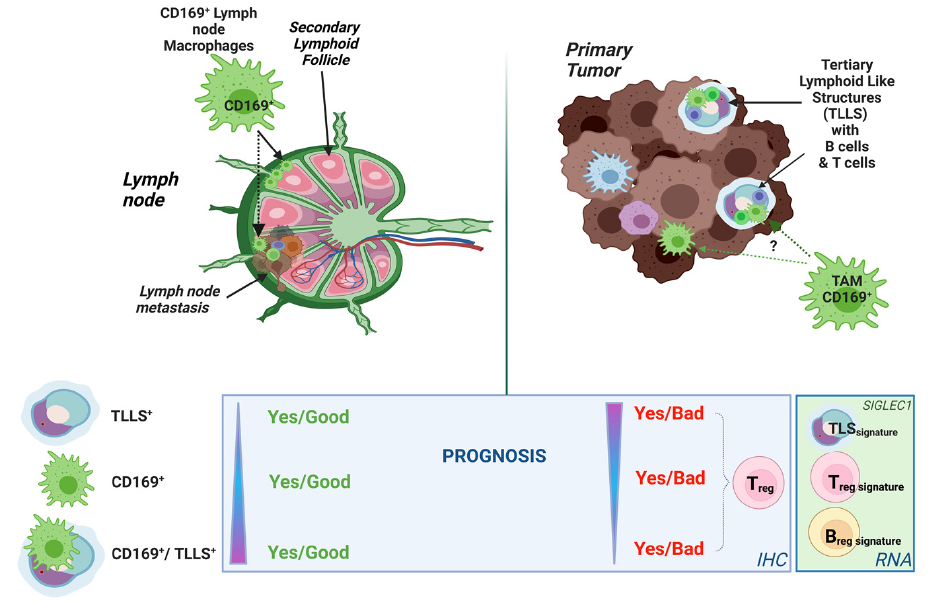
Figure 5. Schematic summary of results. Made in biorender.com. https://biorender.com (accessed on 9 February 2023).